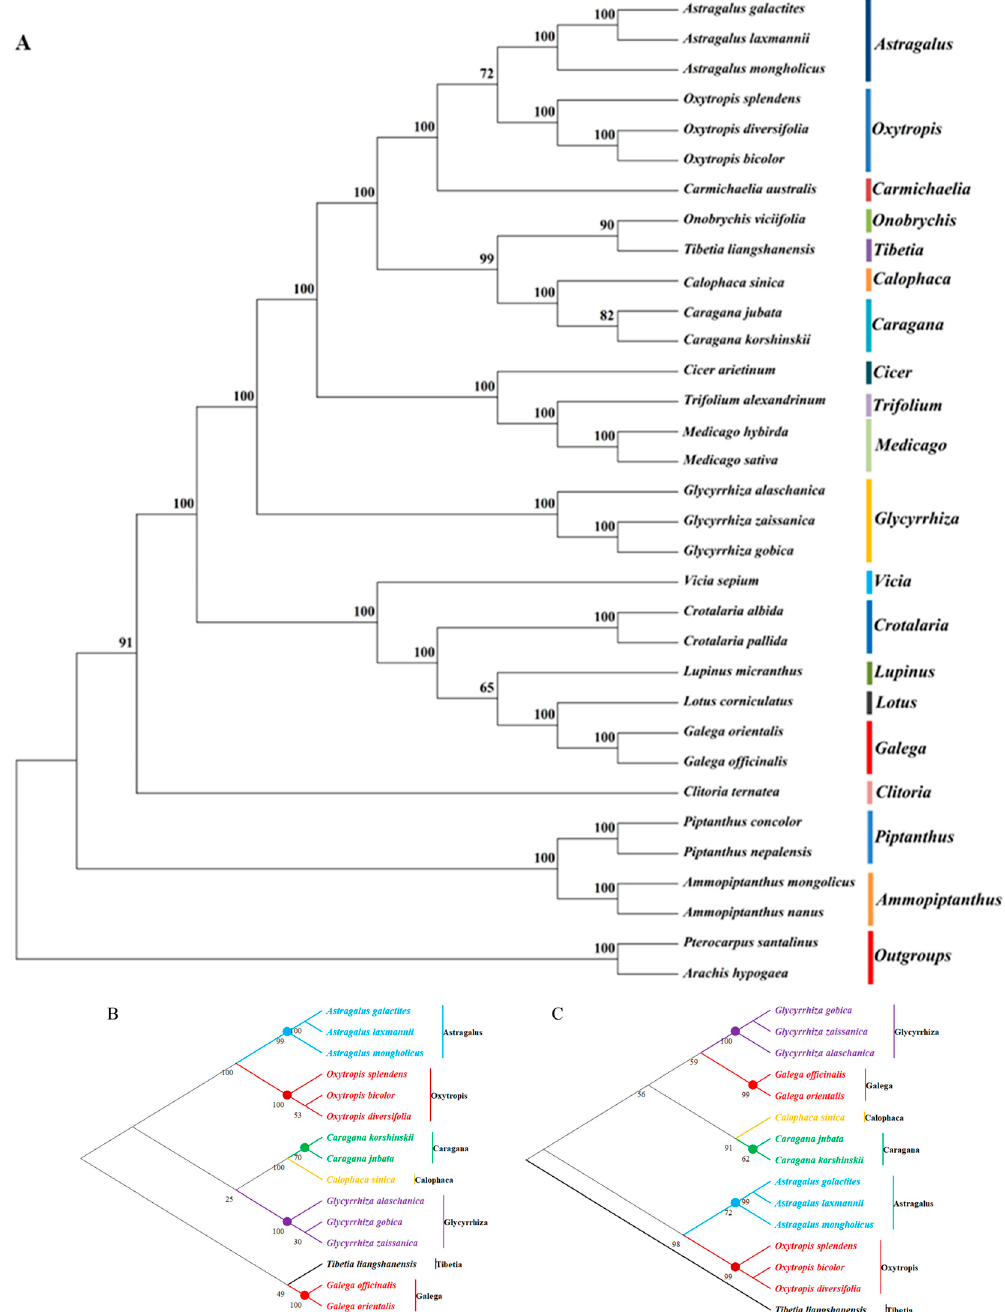
Figure 7. ( A ) Phylogenetic tree of the Leguminosae species ( Galegeae ) based on 31 complete chloroplast genomes and constructed using the ycf1 gene ( B ) and clpP gene ( C ), with the Galega species indicated in red.